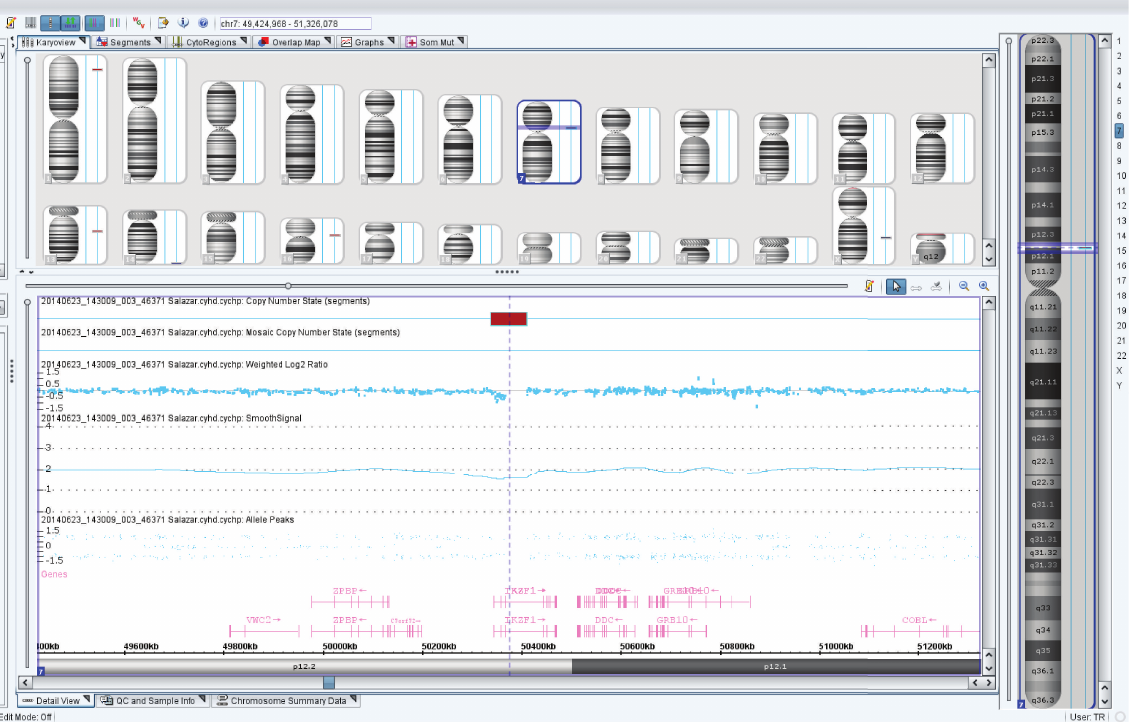
Figure 4: Chromosomal Microarray Analysis showing that the 70 kb deletion at 7p12.2 results in a disruption of the IKZF1